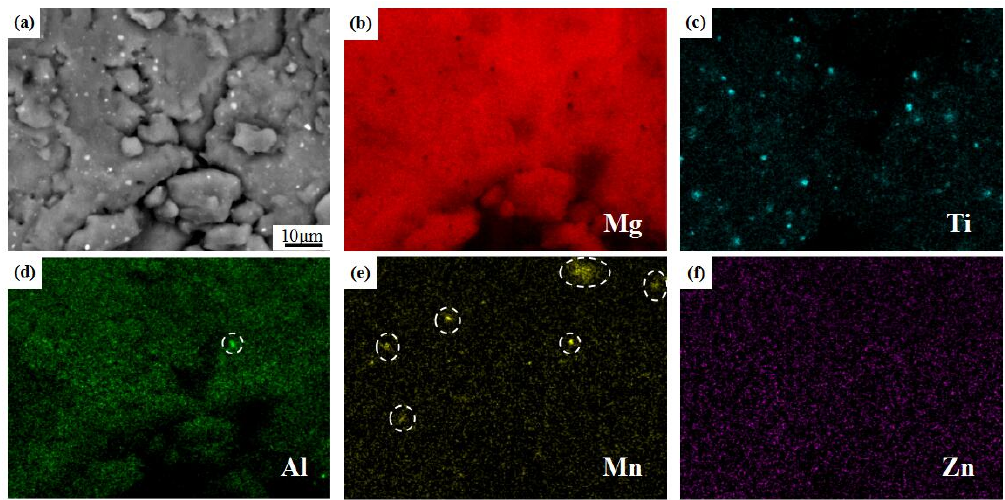
Figure 5. The BSE images of composite powders with 5 wt % TiB 2 addition after milling for different times, and the corresponding EDS results: ( a ) 10 h, ( b ) 30 h, ( c ) 50 h, ( d ) 70 h,( e ) 90 h, ( f ) 110 h, ( g ) EDS results of point A, ( h ) EDS results of point B.